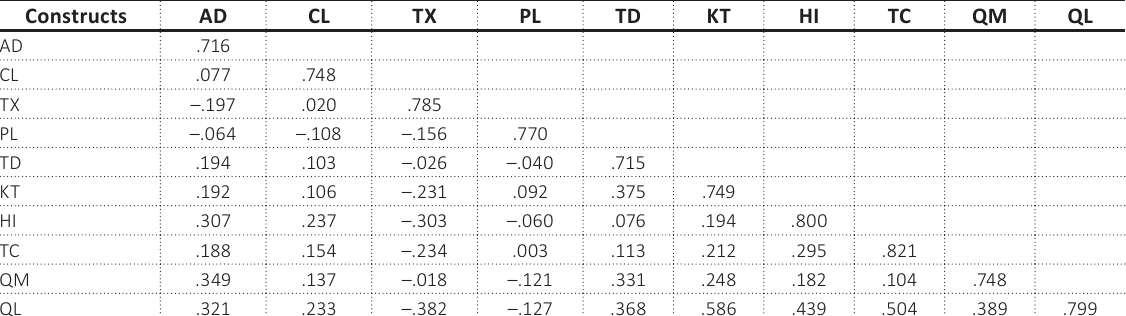
Table 3. Discriminant reliability